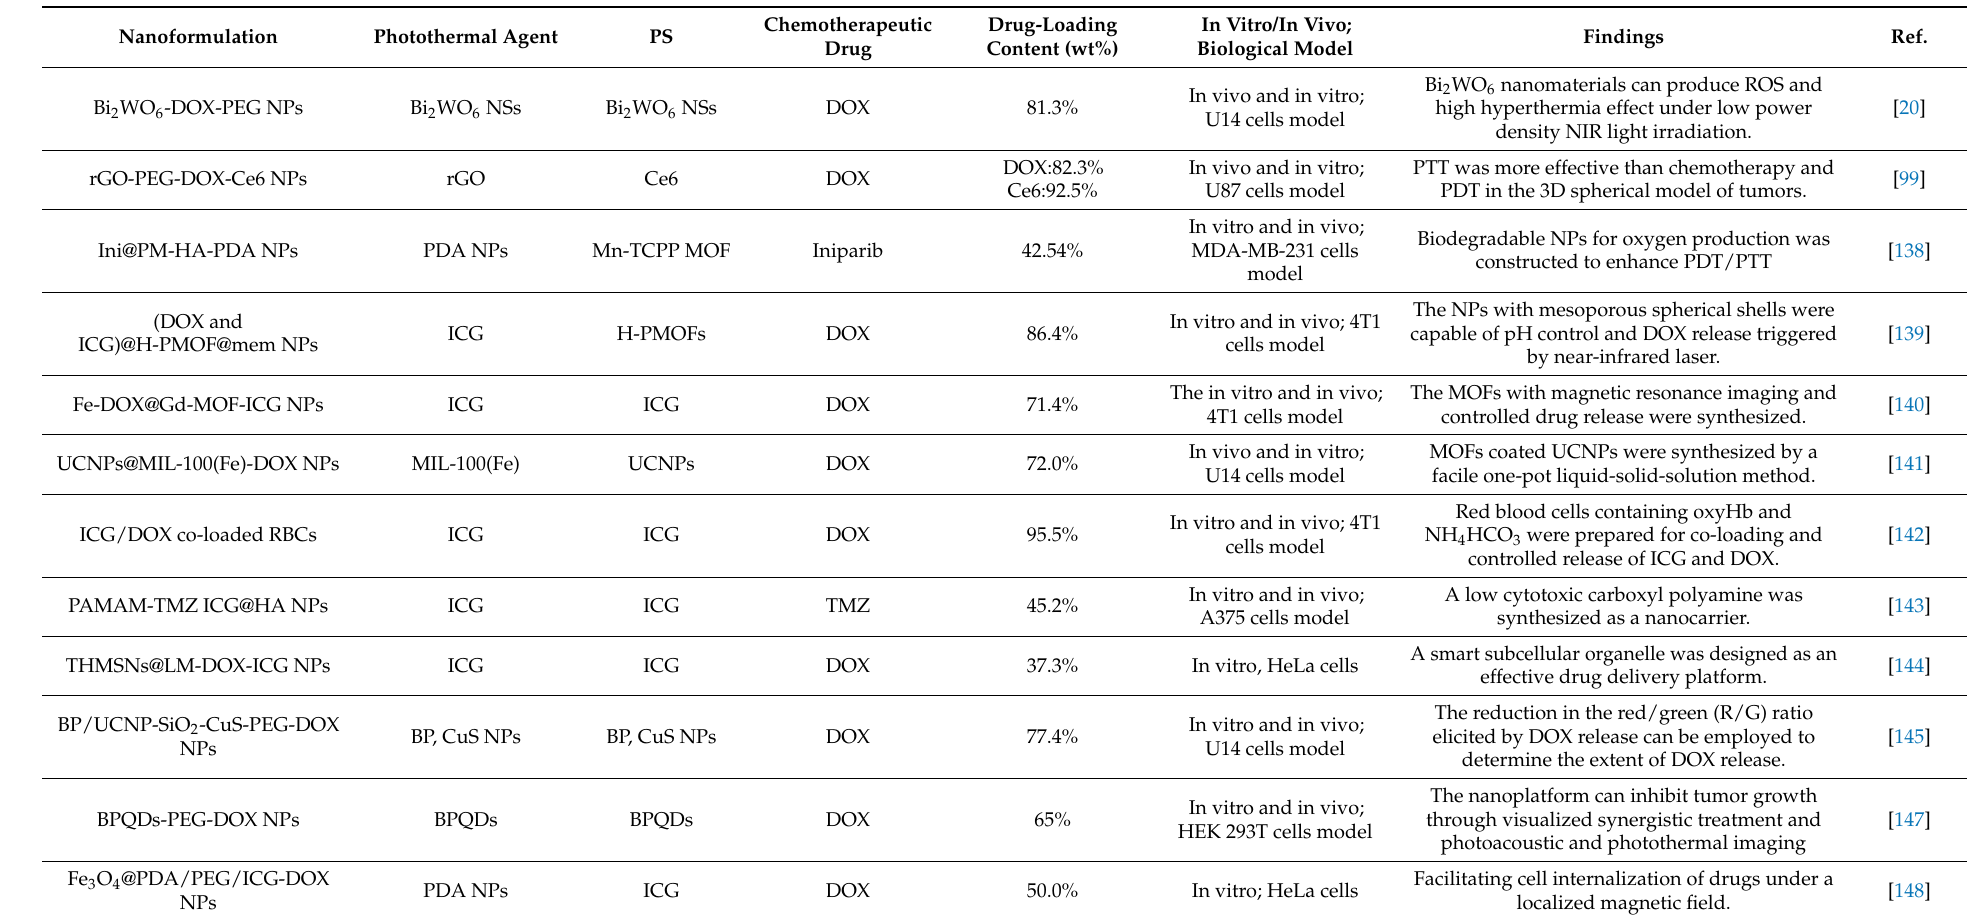
Table 3. A summary of high drug-loading nanomedicines for chemo–photothermal–photodynamic combination